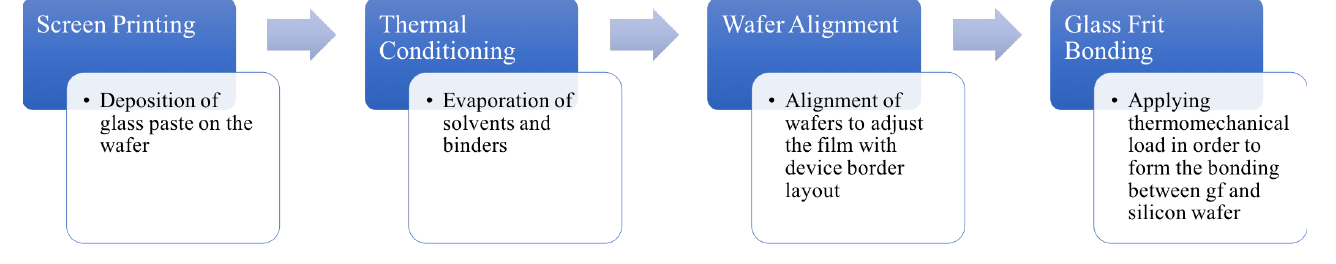
Figure 1. Schematic workflow of glass frit